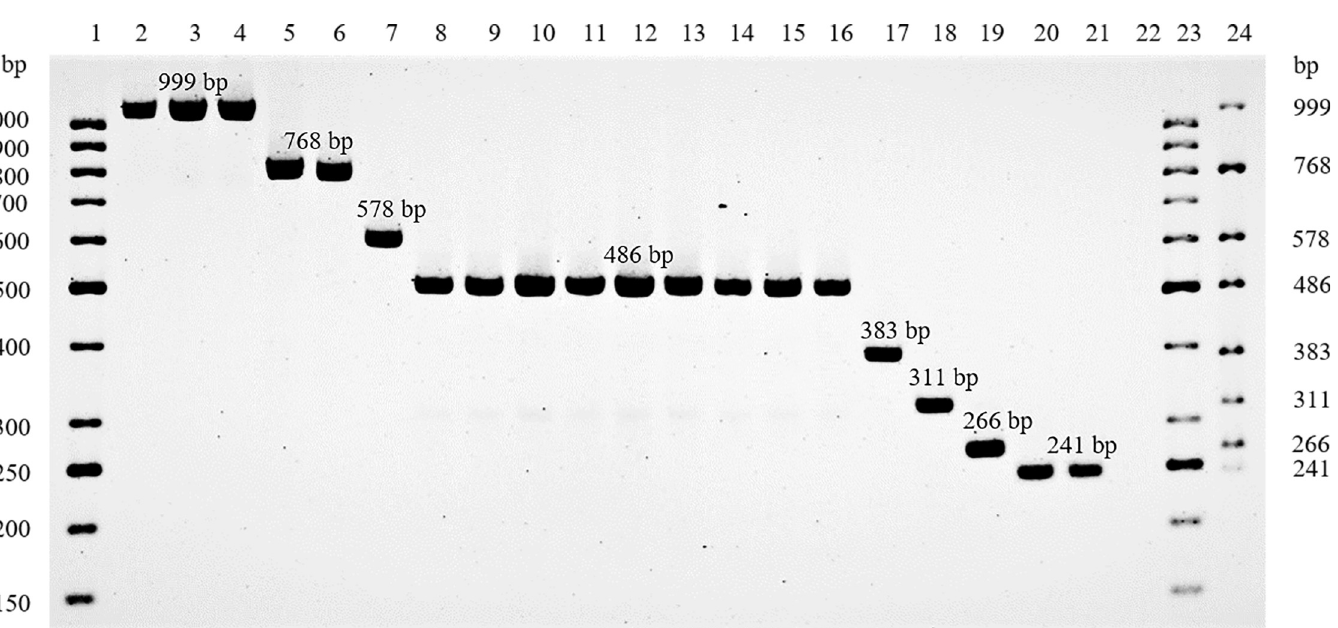
PLOS ONE | https://doi.org/10.1371/journal.pone.0280583 January 20,